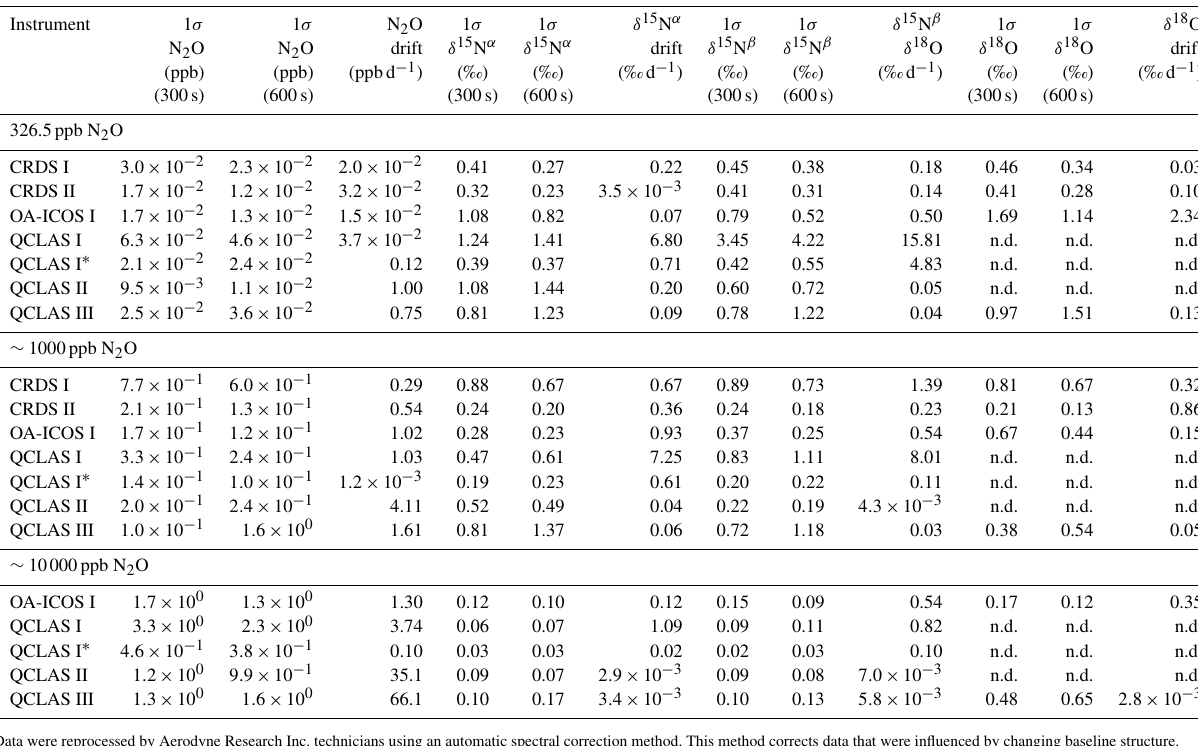
Table 6. Key parameters for instrument stability retrieved from Allan variance experiments for [ N 2 O ] , δ 15 N α , δ 15 N β and δ 18 O: precision (1 σ ) at 300 and 600s averaging times, and daily drift at various N 2 O concentrations. The 1 σ data refer to Allan deviation (square root of Allan variance).